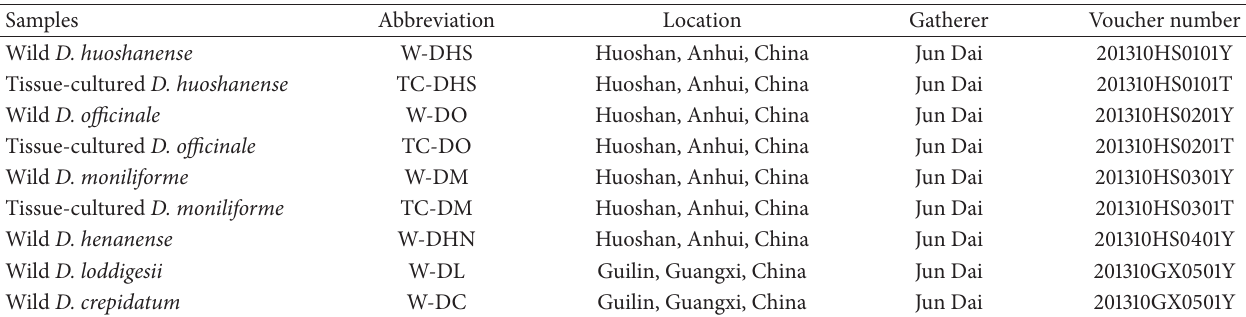
Table 1: The list of Dendrobium